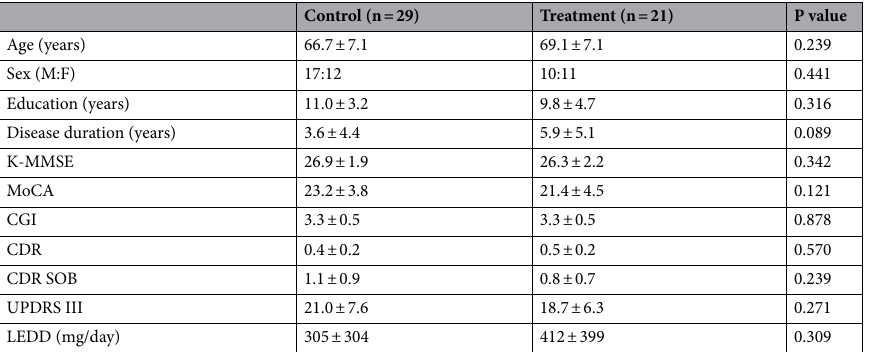
Table 1. Baseline demographics and clinical characteristics. Data are expressed in mean ± standard deviation. Group comparisons were performed using independent t-tests or Fisher’s exact tests as appropriates. P < 0.05 indicates significant difference. CDR clinical dementia rating, CGI Clinical Global Impression, K-MMSE Korean version of mini-mental state examination, LEDD levodopa equivalent daily dose, MoCA Montreal Cognitive Assessment, UPDRS Unified Parkinson’s disease rating